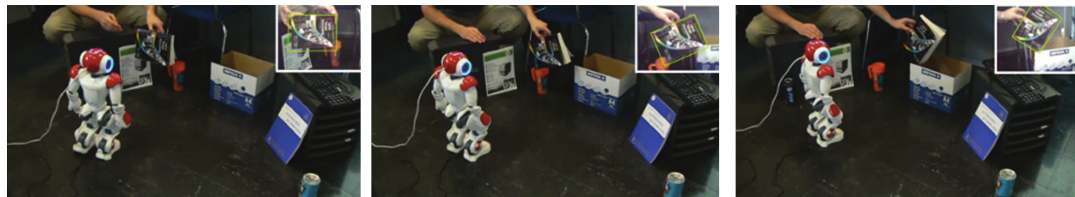
Figure 12: Tracking a previously learned moving object (upper images: video http://www.youtube.com/watch?v = xxz3wm3L1pE). The upper right corner of each image shows robot camera